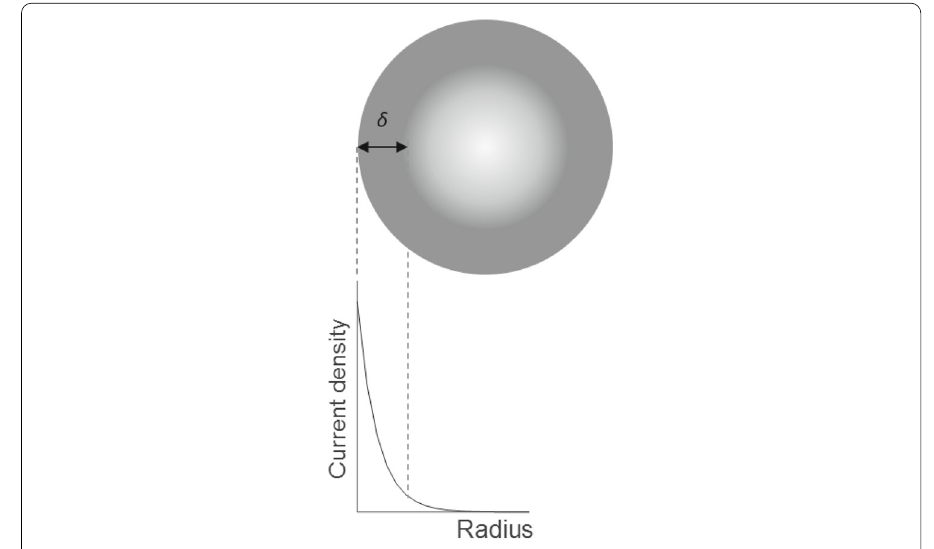
Fig. 1 Exponential decay of the current density as a result of the skin effect in a cylindrical AC